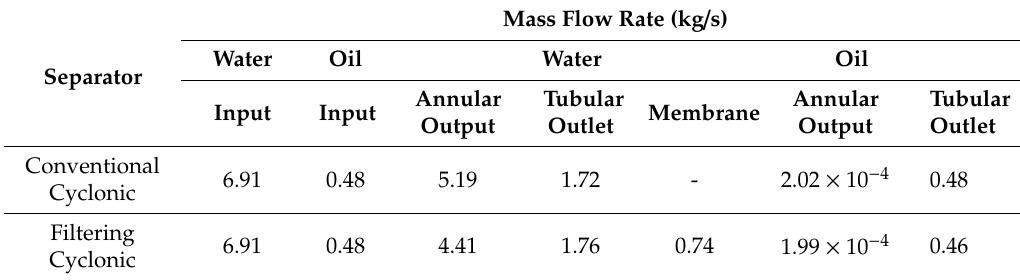
Table 5. The mass flow rate of fluids at the inlets and outlets of the hydrocyclones.